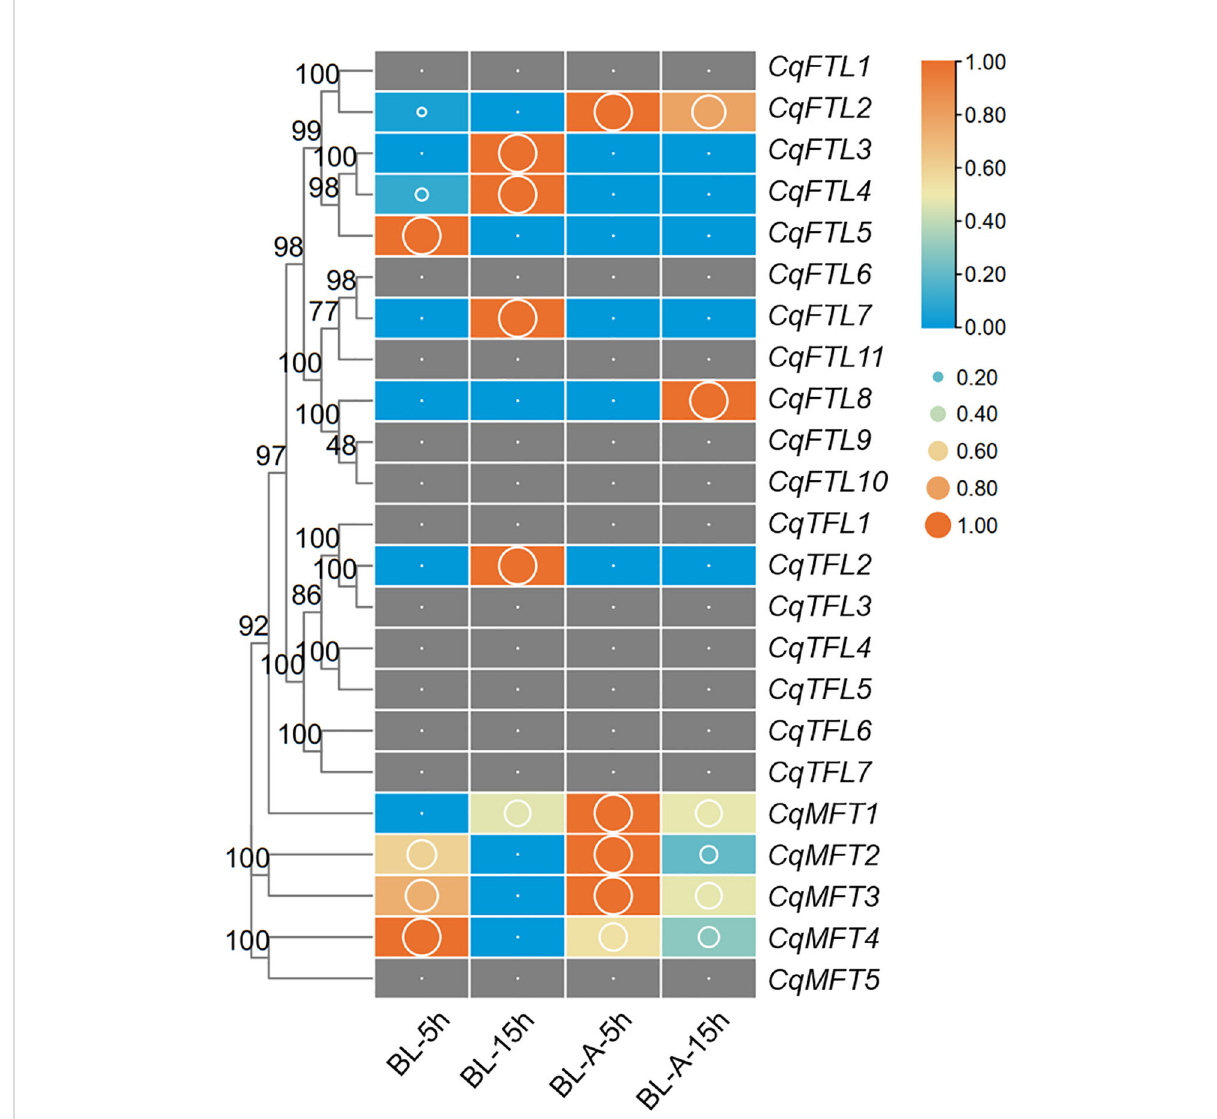
FIGURE 9 Expression changes of PEBP s during seed germination. RNA-seq data of control and ABA-treated seeds at 5h and 15h after imbibition was used to investigate the expression levels denoted by FPKM values (cutoff=0.1) (Wu et al., 2020). BL-A-5h/15h and BL-5h/15h indicate the seeds of cultivar “ BL ” with or without ABA treatment. Each expression value was generated from three replicates. Orange boxes with larger-size bubbles indicate higher expression levels. Expression values in various seed samples of the same gene were normalized to 0 to 1 by